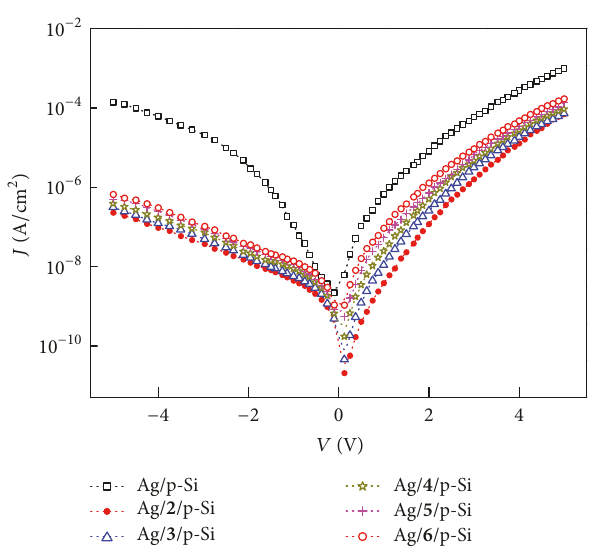
Figure 3: Room temperature 𝐽 - 𝑉 characteristics of the